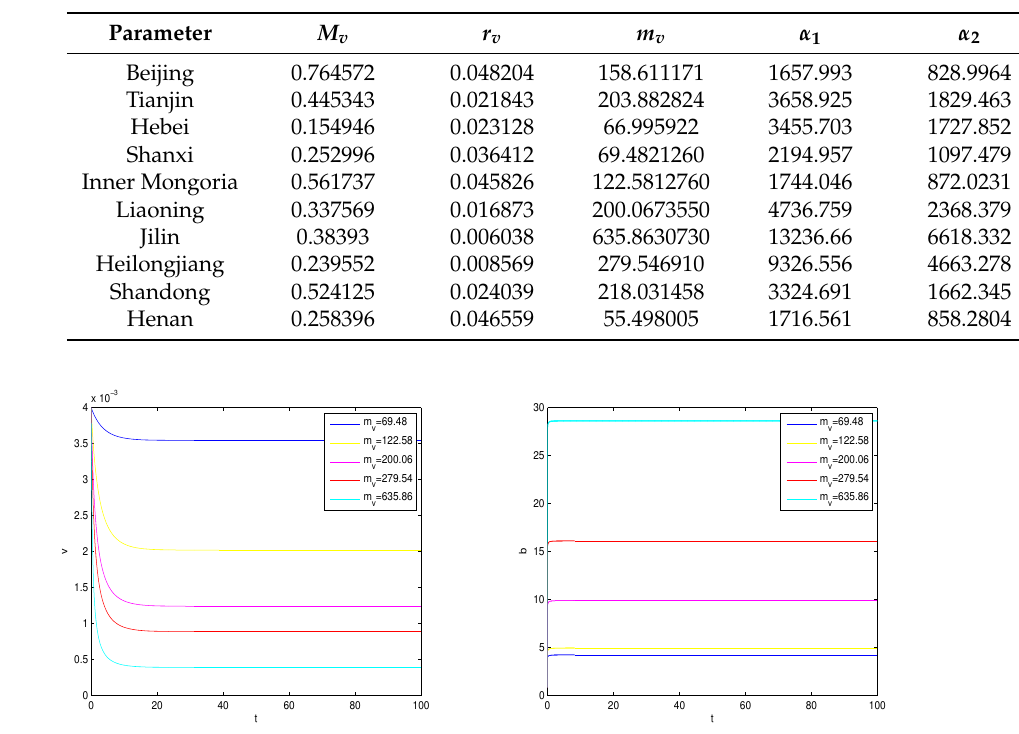
Table 1. The parameter and values to be used in the model (11).